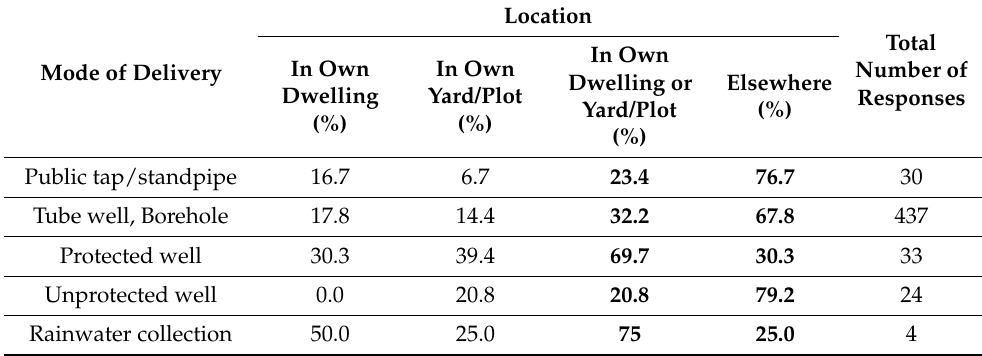
Table 3. Location of the main source of drinking water (Lagos State, %